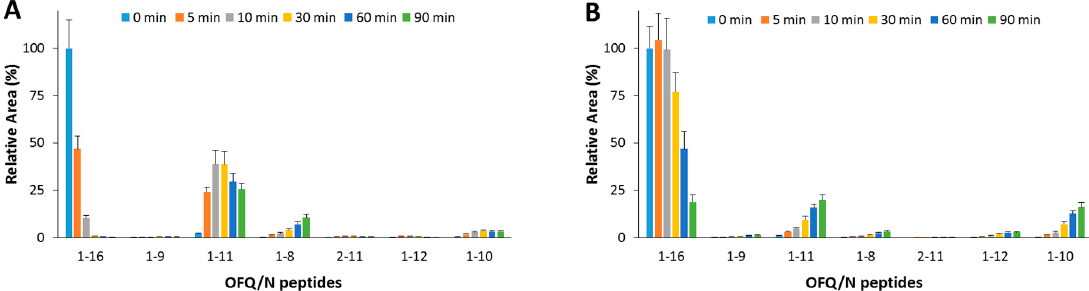
Figure 3. Hydrolytic pattern of the time-course OFQ/N degradation catalyzed by IDE. The content of the full-length substrate (1-16) and the main hydrolytic peptides was detected in the absence ( A ) and in the presence ( B ) of Ins, co-incubated with OFQ/N and IDE at 37 °C for 90 min.